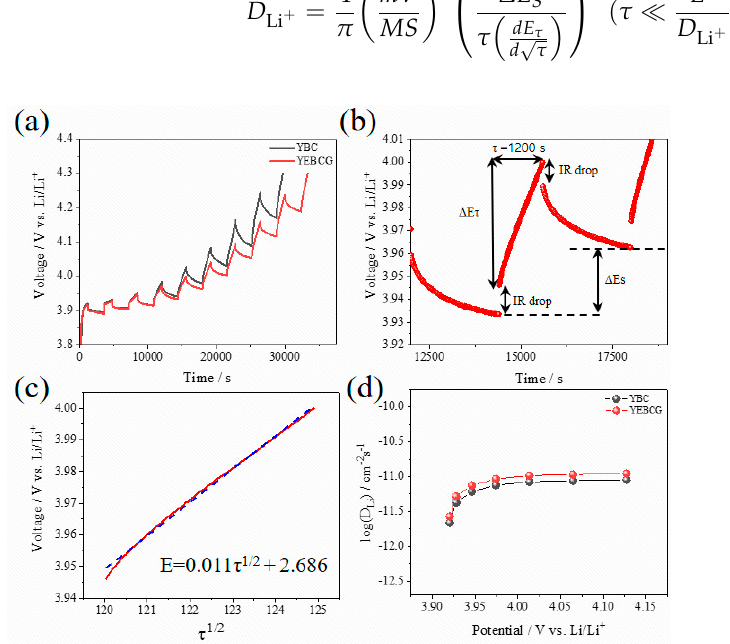
Figure 9. ( a ) GITT curves of Li[YBC] and Li[YEBCG] during the second charge process at a current density of 4.6 mA g − 1 . ( b ) GITT curve at a single titration step of Li[YEBCG] with ( c ) corresponding linear behavior in the relationship of E vs. τ 1/2 . ( d ) Li-ion diffusion coefficients of Li[YBC] and Li[YEBCG] calculated from the GITT curves as a function of the cell potential.